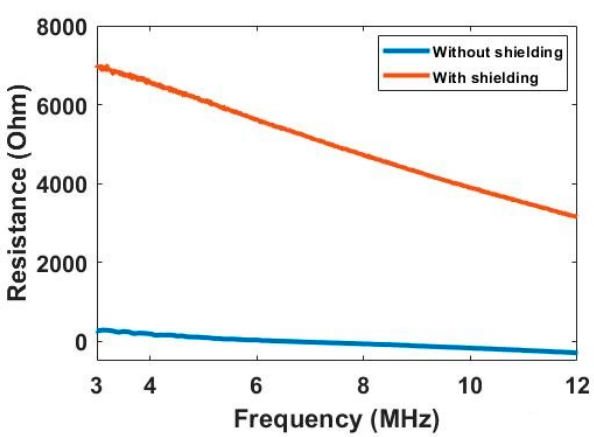
Figure 6. Resistance data of electrode pair 1-4 collected with and without electromagnetic shield.